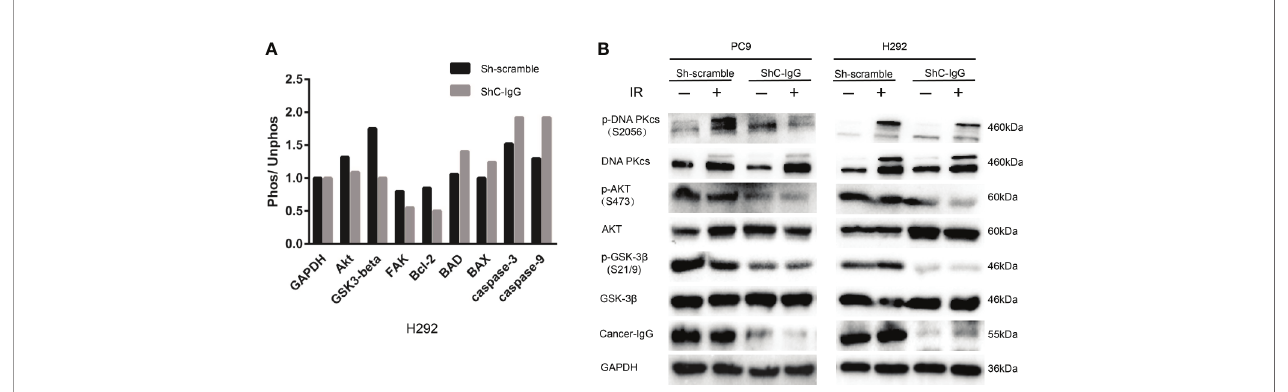
FIGURE 5 | Cancer-IgG mediates radioresistance to LUAD via the PI3K/AKT/DNA-PKcs pathway. (A) An antibody phosphorylation chip was used to detect the phosphorylation changes in key proteins of the signaling pathway after cancer-IgG was silenced. (B) Western blot shows the changes in the expression of DNA- PKcs, p-DNA-PKcs, AKT, p-AKT GSK3 b , and p-GSK3 b of knockdown cancer-IgG under irradiated and